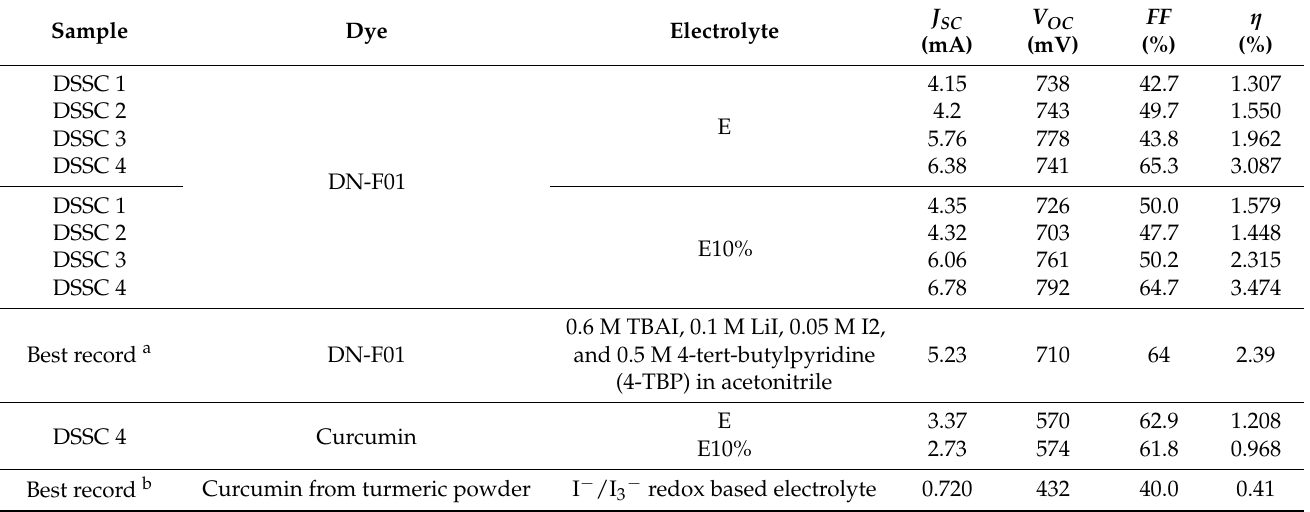
Figure 10. J-V measurements of ( a ) DN-F01and ( b ) curcumin-sensitized DSSC4 with E and E10% electrolytes and under 1 sun (100 mW/cm 2 ) illumination. Table 1. Photovoltaic parameters of the DSSCs tested using E and E10% electrolytes and both synthetic and natural dyes.